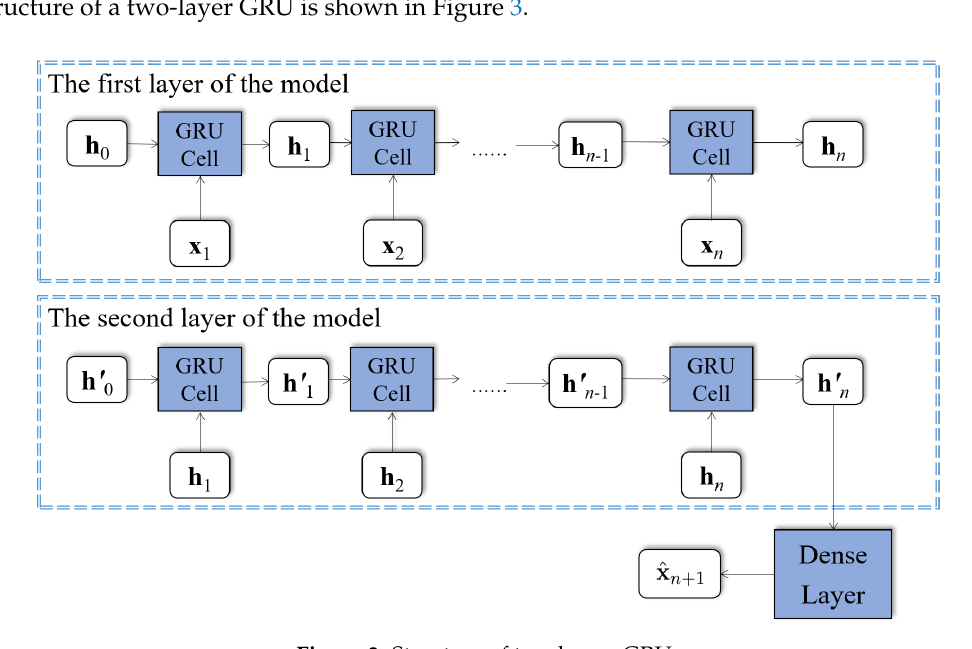
Figure 3. Structure of two layers